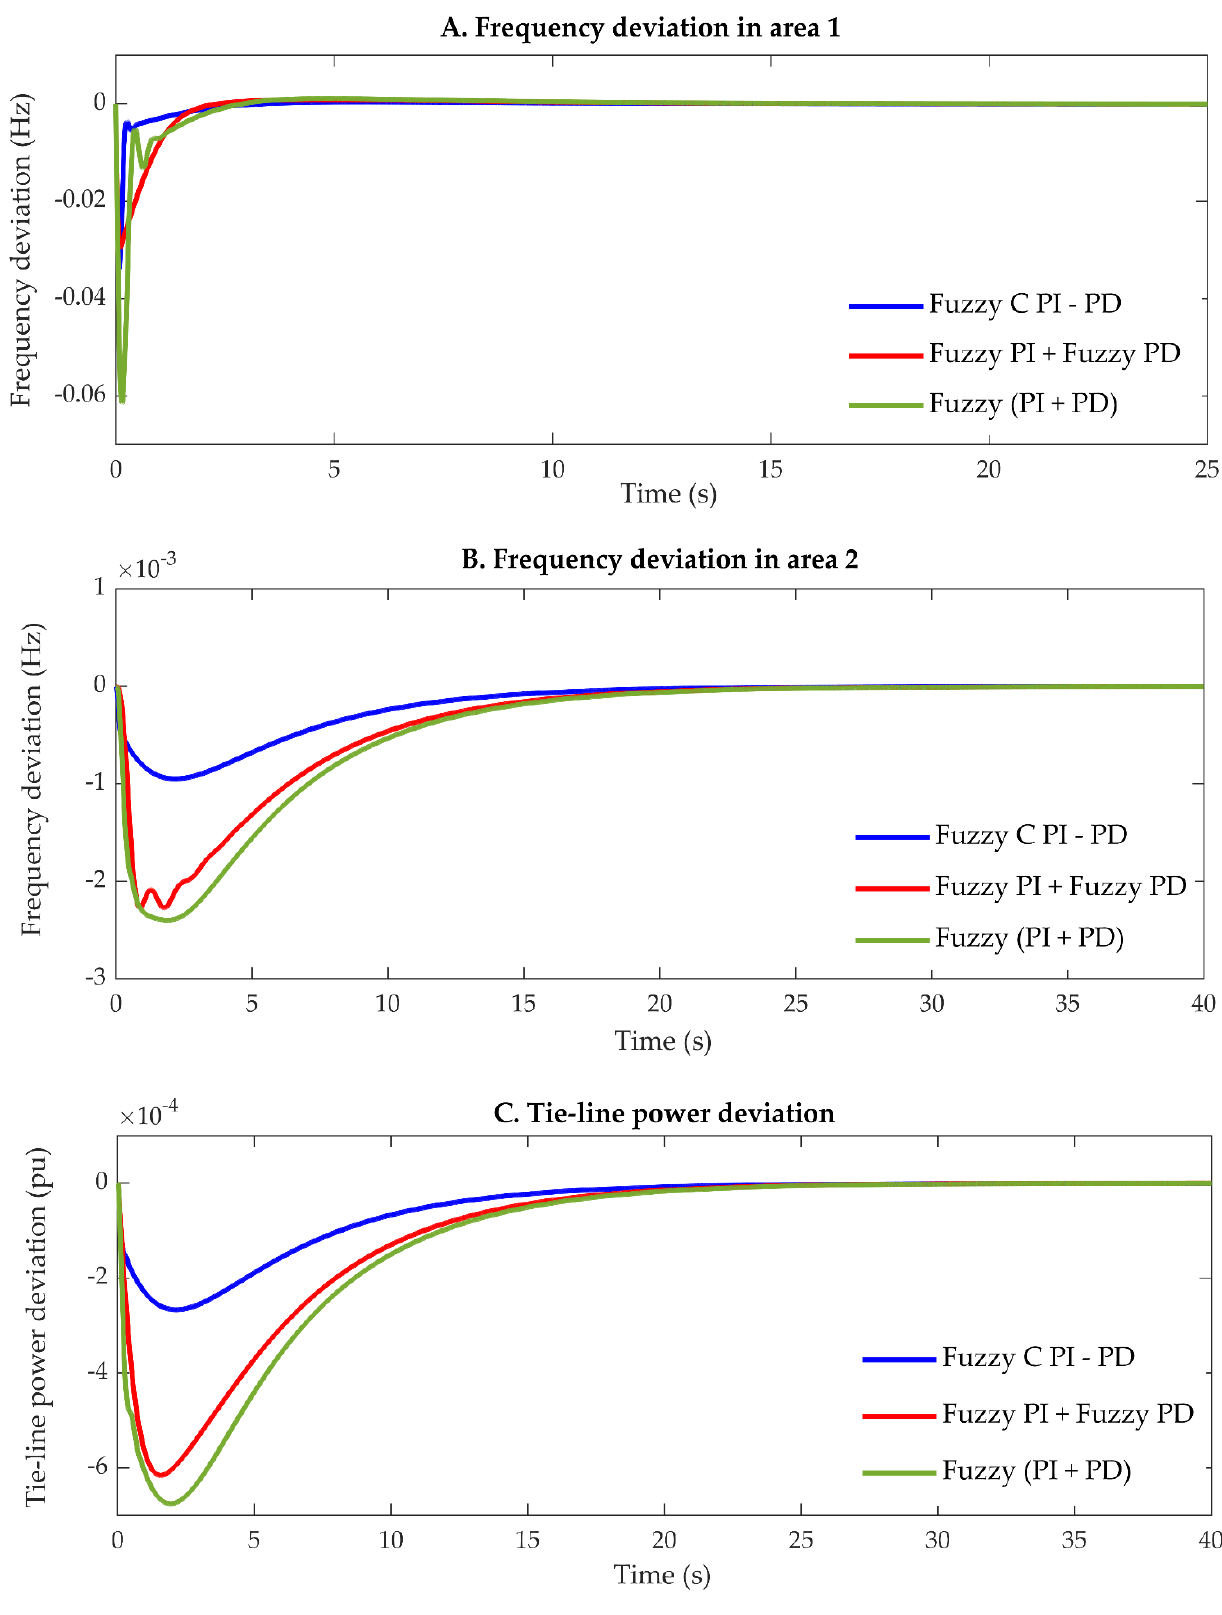
Figure 22. Dynamic response of the testbed power system based on different fuzzy controllers under parametric uncertainty conditions, case 1. ( A ) Frequency variation in area 1; ( B ) frequency variation in area 2; ( C ) tie-line power variation.